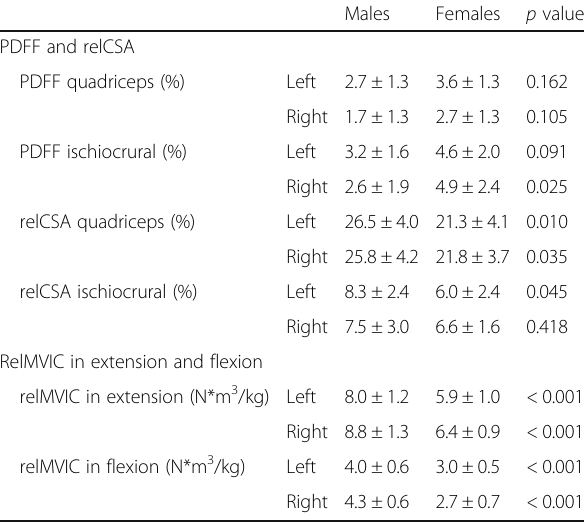
Table 1 Proton density fat fraction (PDFF), relative cross- sectional area (relCSA), and relative maximum voluntary isometric contraction (relMVIC) in extension and flexion